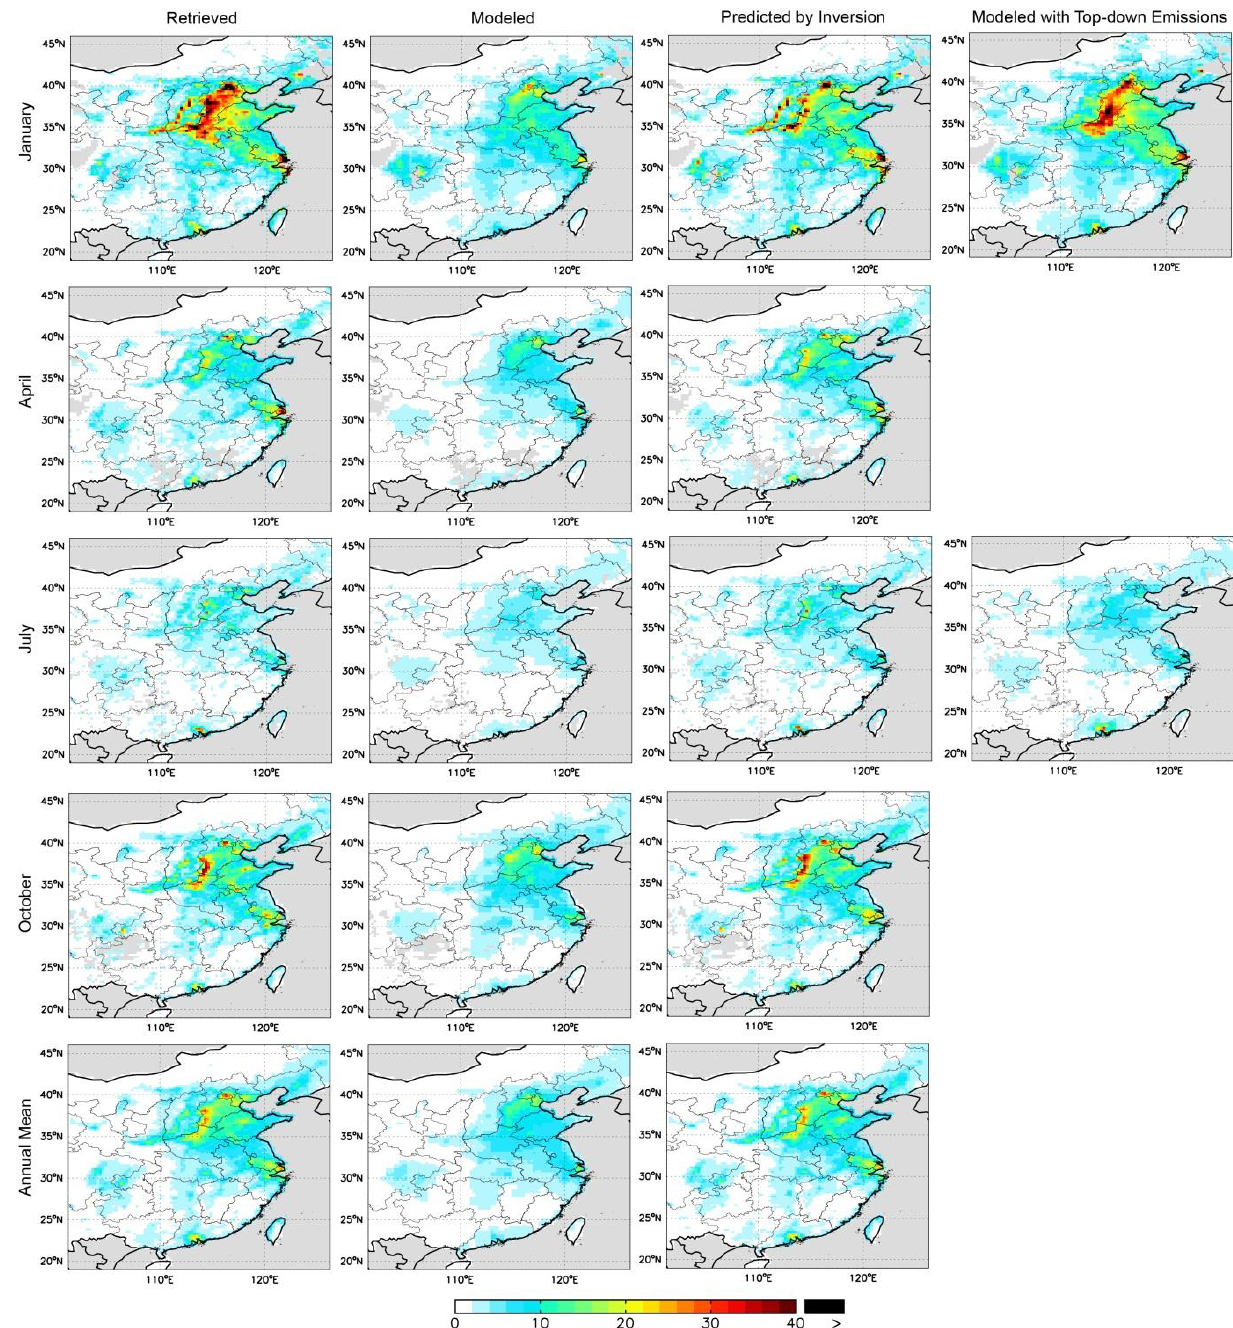
Fig. 4. VCDs of NO 2 (10 15 molec.cm − 2 ) for January, April, July, October and annual average for 2006 retrieved from OMI, simulated by GEOS-Chem with a priori emissions, predicted by the inversion approach, and simulated by GEOS-Chem with top-down emissions. Areas outside the territory of China or without valid retrievals are shown in